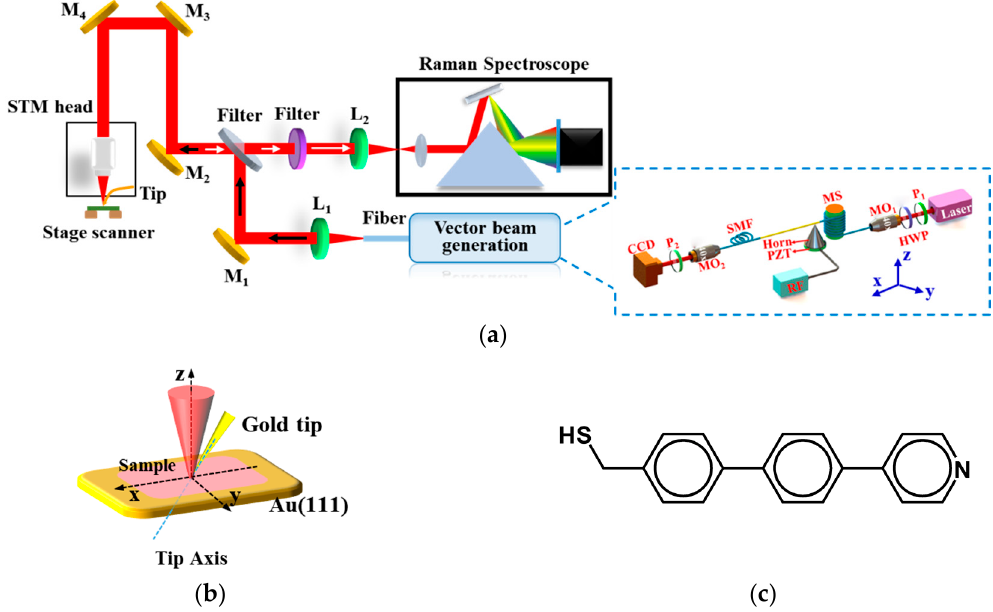
Figure 2. ( a ) Experiment configuration of tip-enhanced Raman spectroscopy ( TERS) excited by the high-order fiber vector beams. Inset: setup for the high-order fiber vector beam generator based on electrically-controlled acoustically-induced fiber grating; ( b ) partial enlarged detail of the metallic tip and sample; ( c ) chemical structure of the 4-PBT (4-thiol-4’-(4-pyridine)biphenyl).